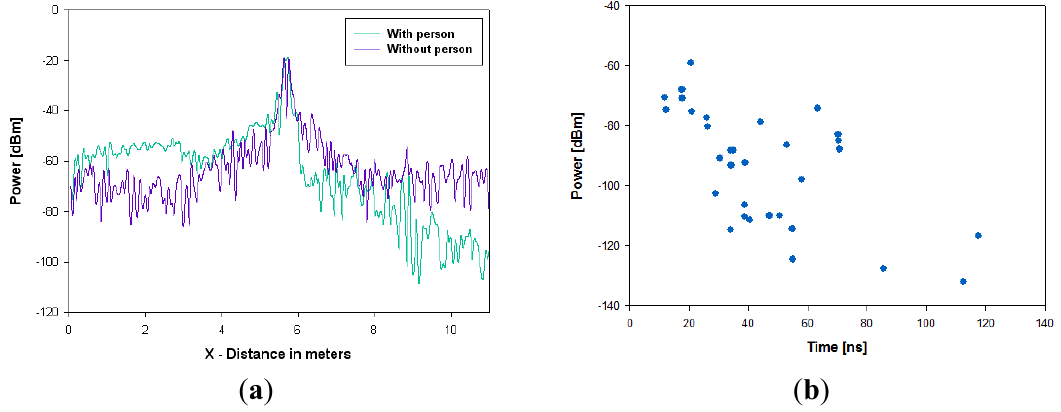
Figure 8. ( a ) Distribution of Power for Y = 4.67 meters along the X-axis for both cases, with and without the presence of a person ( b ) Power-Delay Profile at Point (3.41, 4.67, 1.35) meters in the indoor scenario.